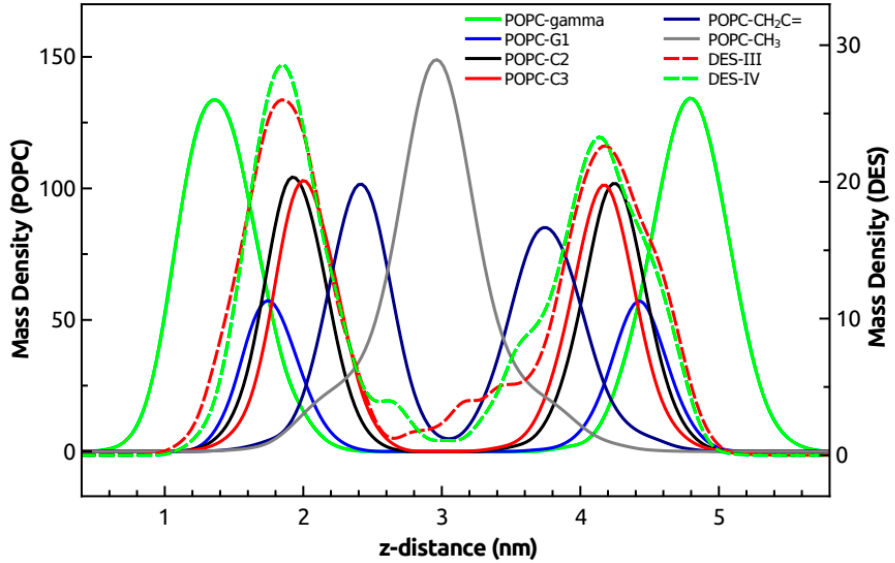
Figure 7. Mass density profiles along the z -axis of the membrane (normal to the bilayer) are shown for the gamma (green), G1 (blue), C2 (black), C3 (red), CH 2 C = (dark blue), and methyl terminal (gray) groups of POPC (continuous lines and left axis) and the III (red) and IV (green) groups of DES (dashed lines and right axis). Mass density units are in kg · m − 3 .